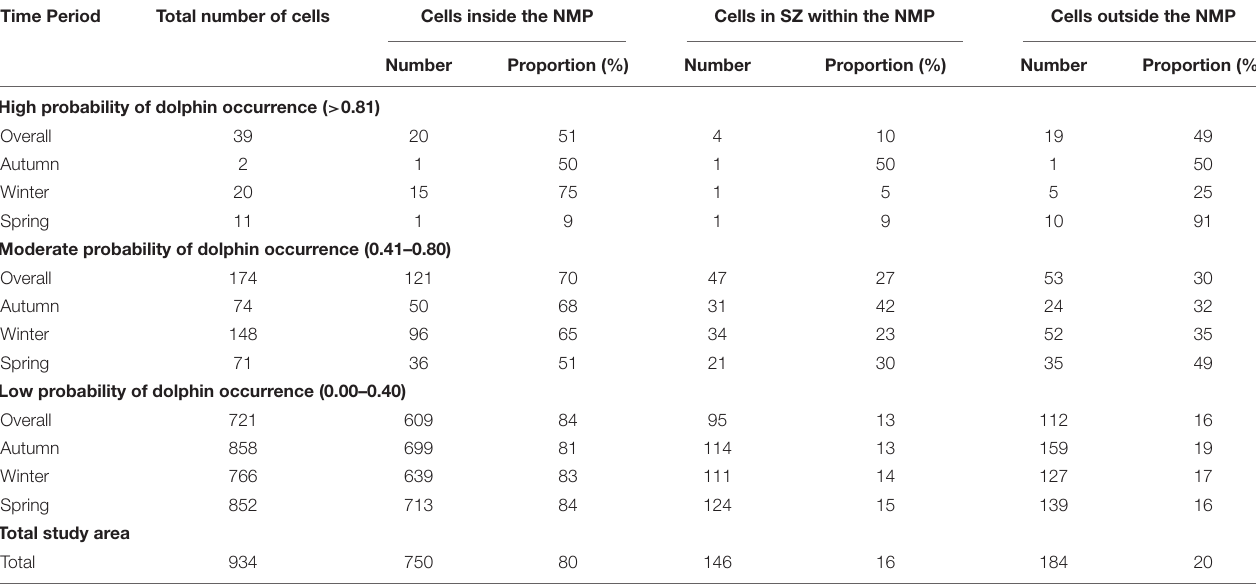
TABLE 4 | Number and proportion (%) of cells with high ( > 0.81), moderate (0.41–0.80), and low ( < 0.40) probability of Indo-Pacific bottlenose dolphin occurrence inside and outside the Ningaloo Marine Park (NMP), as well as those cells inside the marine park that fell within designated sanctuary zones (SZ). Time Period Total number of cells Cells inside the NMP Cells in SZ within the NMP Cells outside the